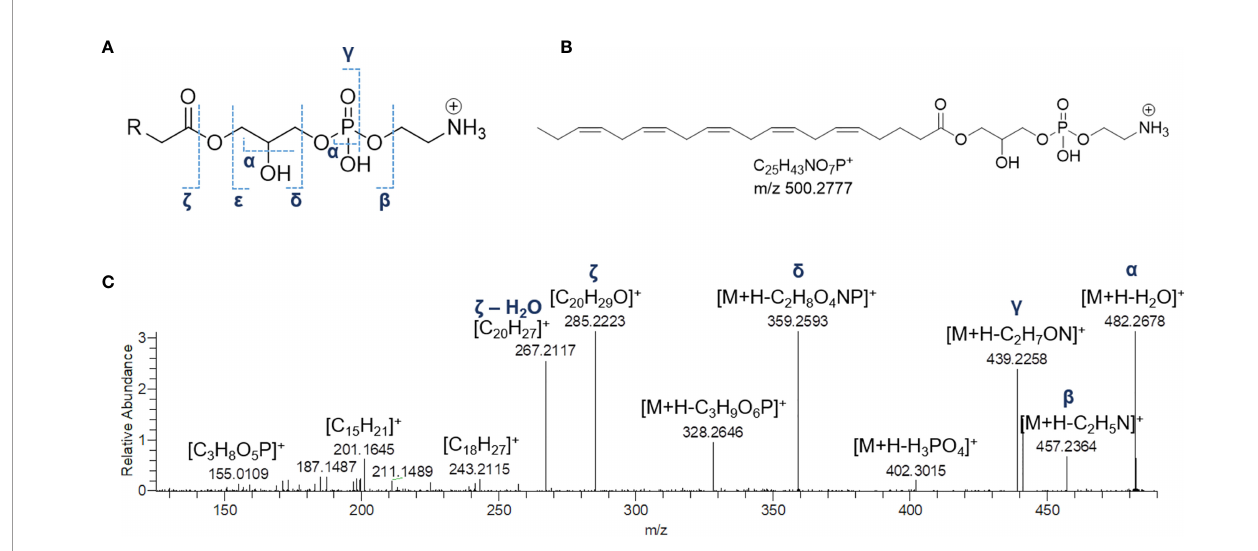
FIGURE 5 | The fragmentation patterns of lyso-phosphatidylethanolamines (A) . Chemical structure of a representative lyso-phosphatidylethanolamine from Botrylloides niger , namely 1-(5Z,8Z,11Z,14Z,17Z-eicosapentaenoyl)-glycero-3-phosphoethanolamine (LPE 20:5) (B) and HR ESI-MS 2 spectrum of the relevant [M+H] + adduct (C)